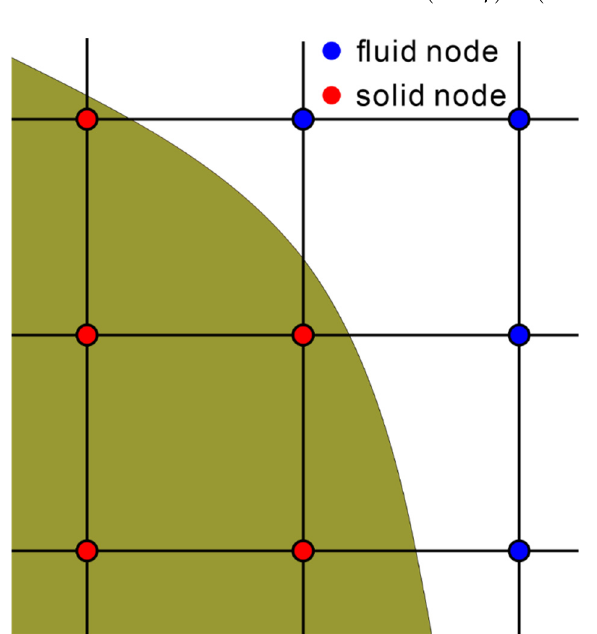
Figure 3. Noble and Torczynski’s scheme